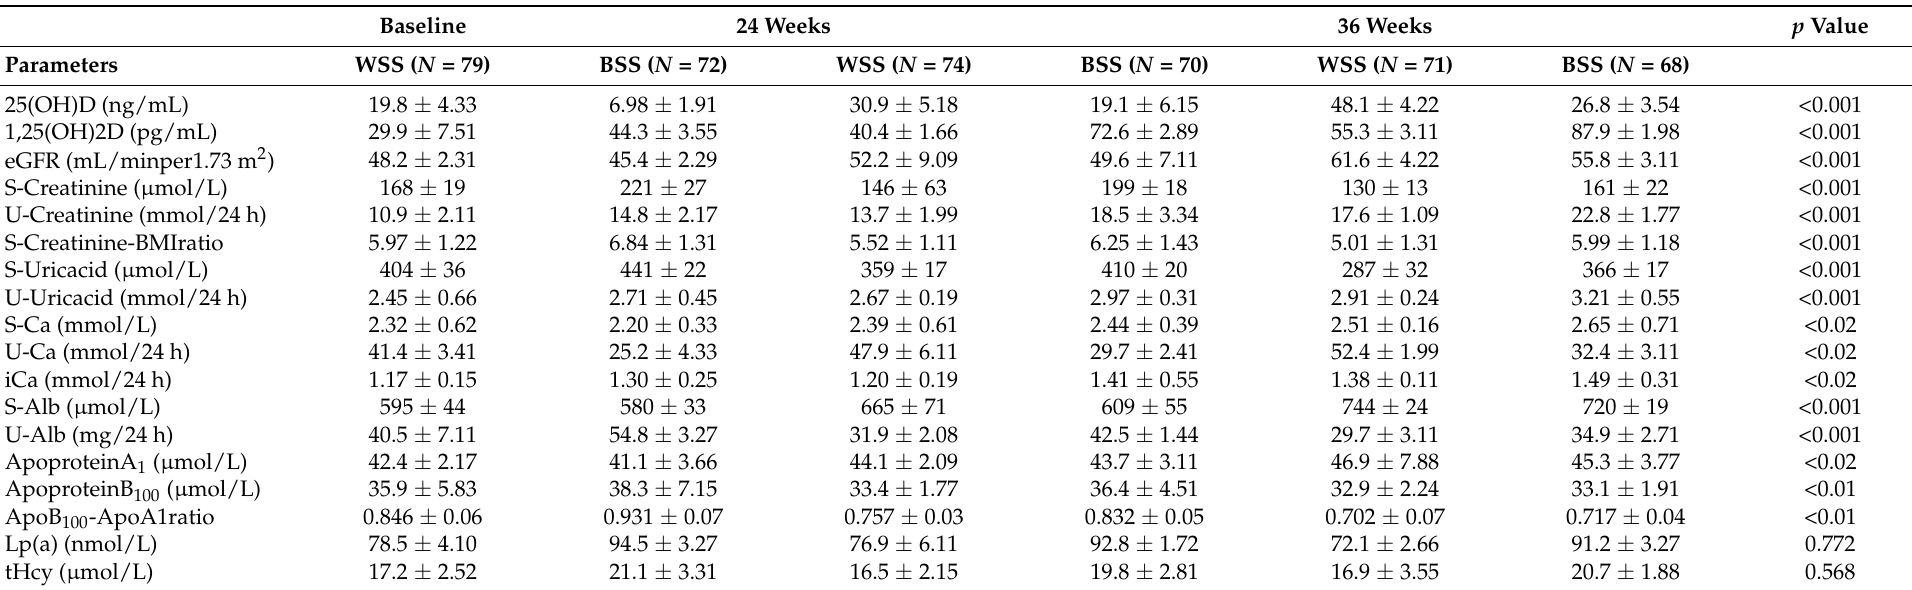
Table 4. Effects of oral 2000 IU vitamin D3 supplementation/day at 24 and 36 weeks on serum vitamin D level, CKD clusters and thromboembolic biomarkers in Blacks versus Whites SS